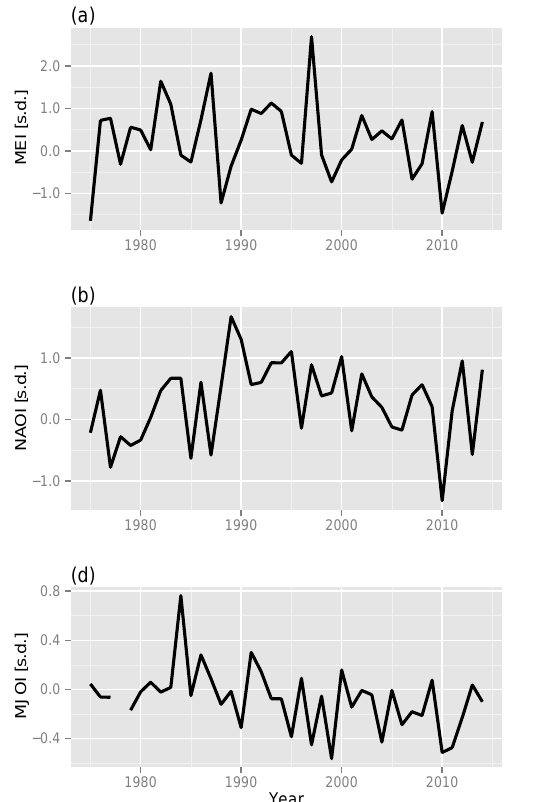
Figure 7. Time series of (a) monthly average of MEI from 1975 to 2014, (b) monthly average of NAOI from 1975 to 2014, and (c) monthly average of MJOI from 1975 to 2014. Due to missing outgoing long-wave radiation data, 1979 is missing from the MJOI.